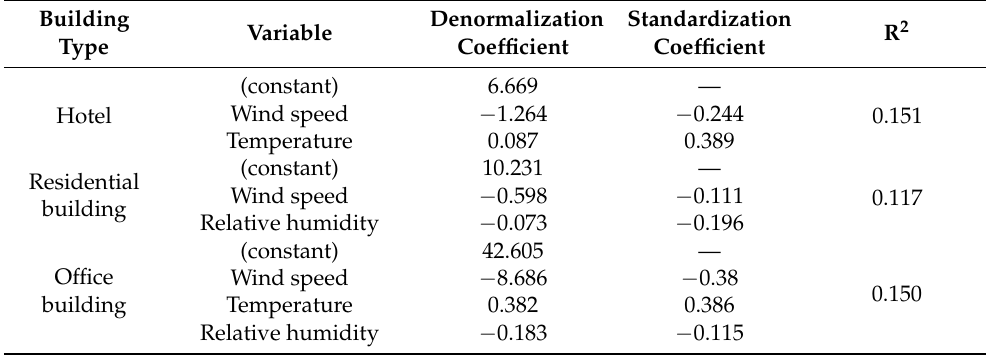
Table 7. Stepwise regression results of climate factors and building electricity EUI.